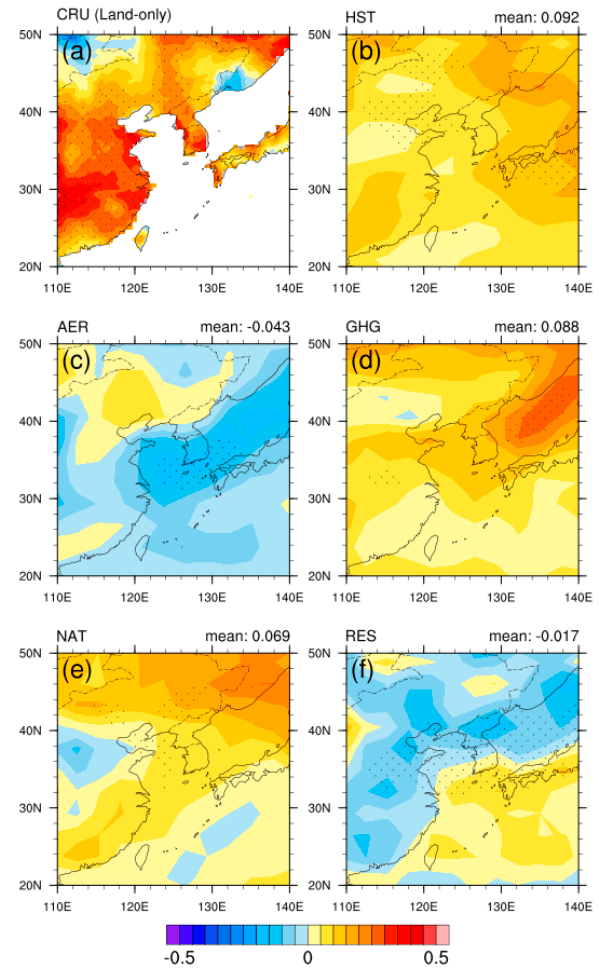
Figure 4. The linear trends in the JJA-mean TAS (K decade − 1 ) for P1 (1911–1940) from ( a ) the CRU data, ( b ) HST, ( c ) AER, ( d ) GHG, and ( e ) NAT runs, and the corresponding ( f ) RES. The dotted area indicates that the TAS trends are statistically significant at the 10% level. The domain average value is shown in the right corner.